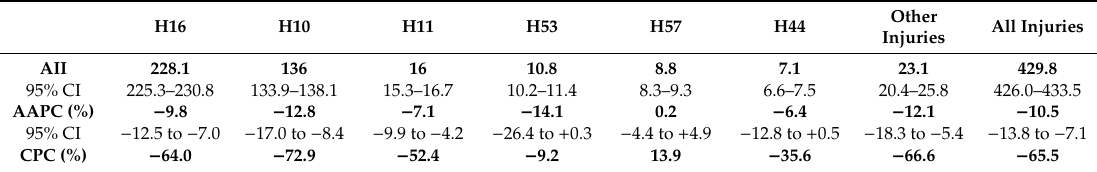
H16 = keratitis; H10 = conjunctivitis; H11 = other disorders of conjunctiva; H53 = visual disturbances; H57 = other disorders of eye and anexa; H44 = disorders of globe. AII = average injury incidence per 100,000 insured workers. AAPC (%) = average annual percent change (2008–2018). CPC (%) = cumulative percentage change